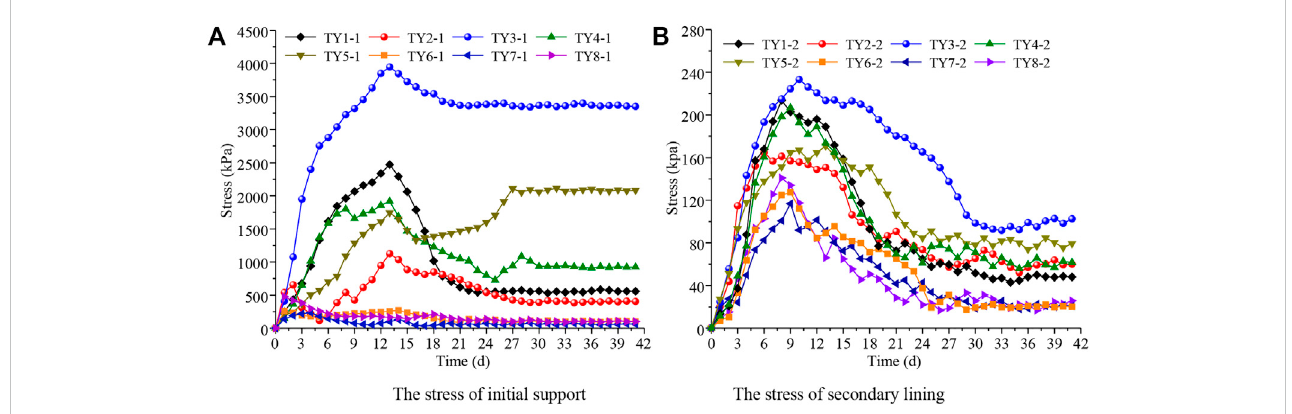
FIGURE 13 Time-history characteristic curves of surrounding rock stress on supporting structures. (A) The stress of initial support (B) The stress of secondary lining.